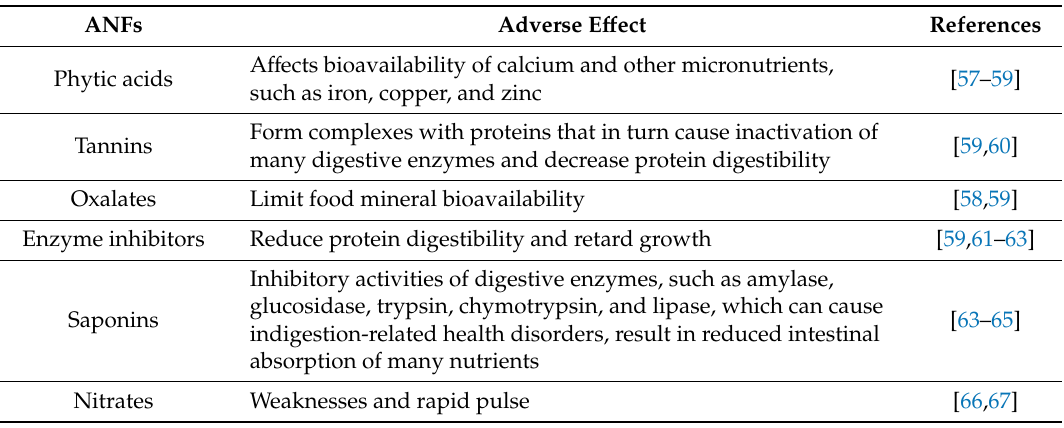
Table 3. Key anti-nutritional factors found in